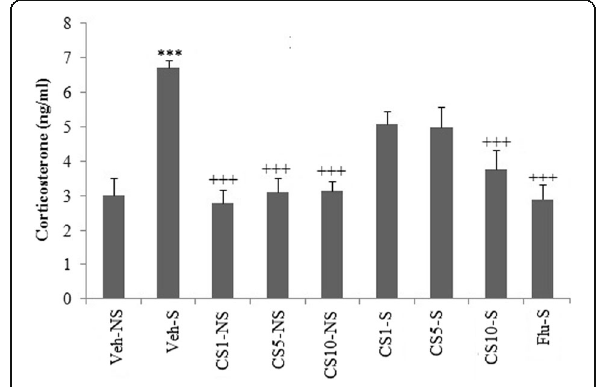
Fig. 2 Effect of CS and Flu (positive control) on corticosterone levels in serum of immobilization stress and control groups ( n = 8, for each group). Each measurement was done at least in triplicate and the values are the means ± SEM for eight rats in each group. Significantly different from the Veh-NS groups (***; P < 0.001). Significantly different from the Veh-S groups (+++; P <